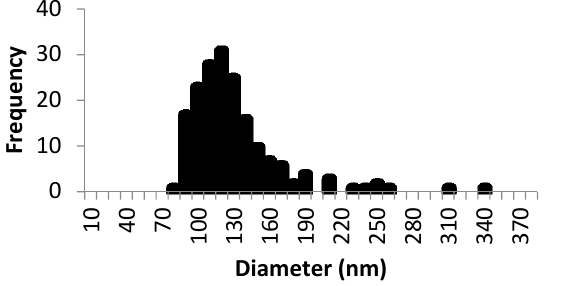
Figure 3. Histogram of lipomers from the measurement of the diameter of the particles ( n = 180) using ImageJ software.